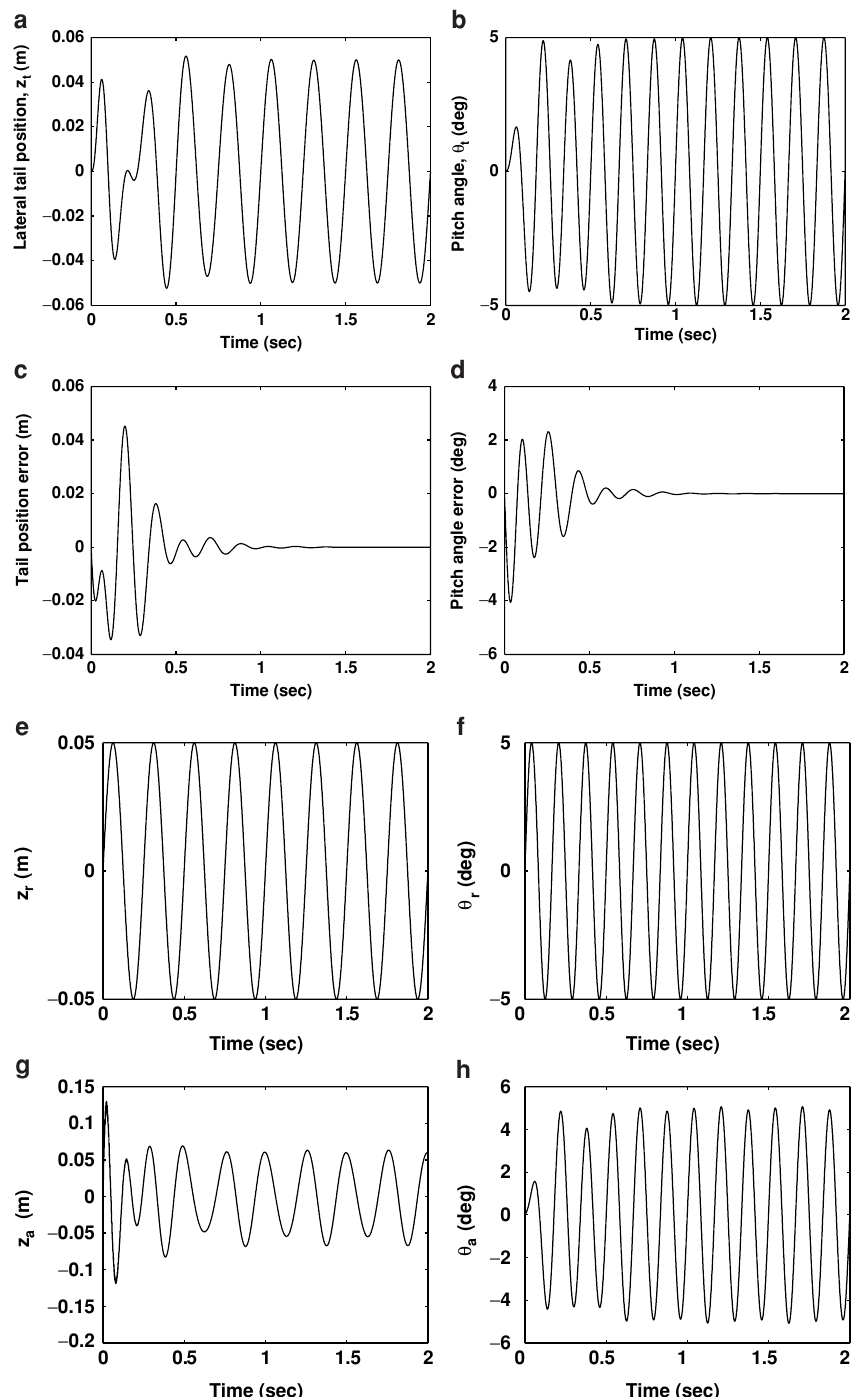
Figure 2 Oscillation control: ω z = 4, ω θ = 6 rad/s. (a) Lateral position, z t (m), (b) pitch angle, θ t ( ◦ ), (c) tail position error, z t − z r (m), (d) pitch angle error, θ t − θ r ( ◦ ), (e) reference trajectory, z r (m), (f ) reference trajectory, θ r ( ◦ ), (g) control input, z a (m), (h) control input, θ a ( ◦ ), (i) state, x f SIMULATION